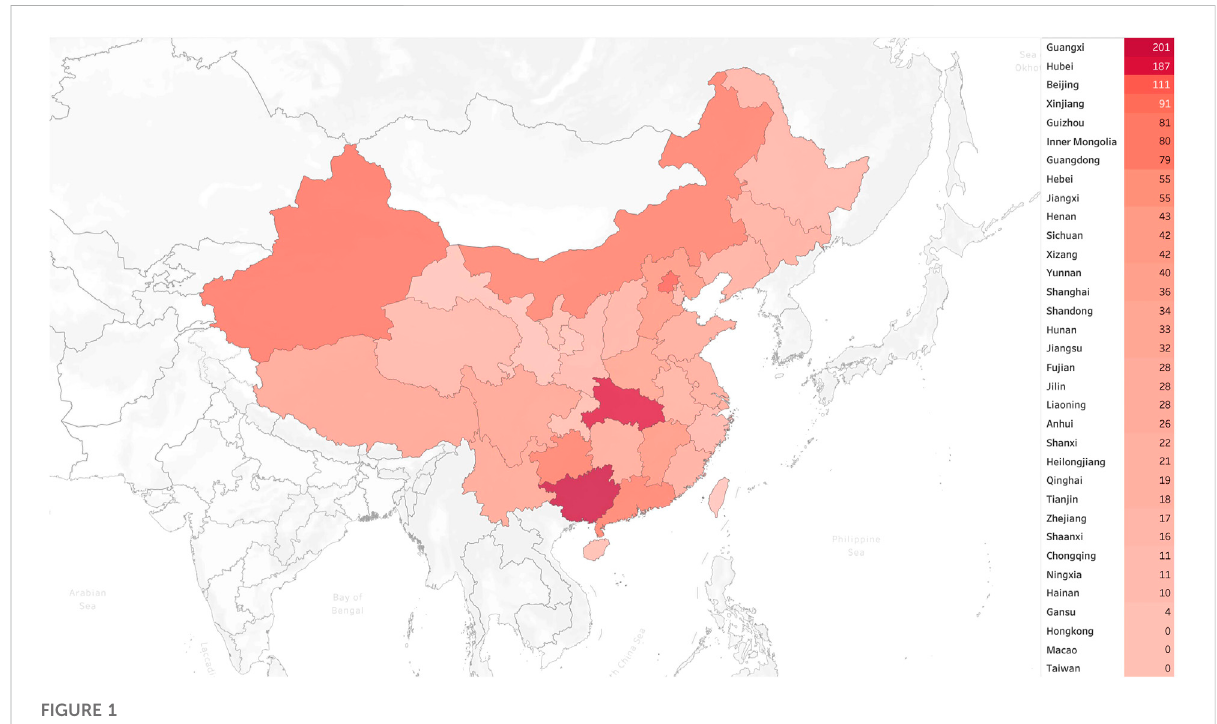
FIGURE 1 Geographical distribution of all respondents ( n = 1501) in